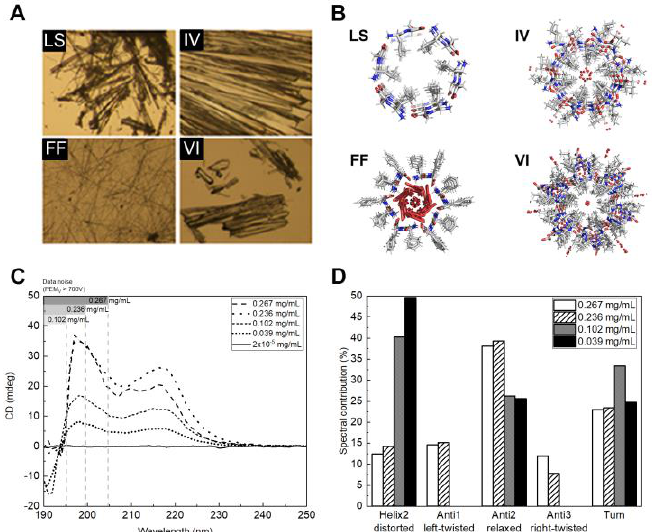
Figure 1. ( A ) Optical microscope image of LS, FF, IV and VI crystals; ( B ) Crystal structures of the dipeptides nanotubes along the c crystallographic axis; ( C ) CD spectra for FF crystals at different concentrations; and ( D ) spectral contribution of the different secondary structures for the several crystal concentration (mg/mL) sample.